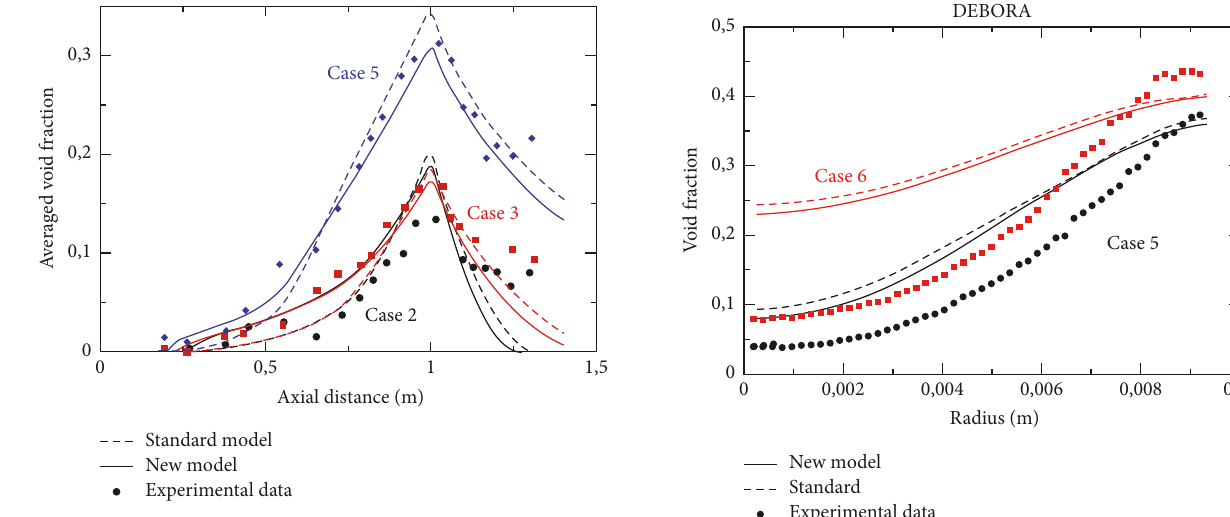
Figure 51: Bartolomei cases 2 (black), 3 (red), and 5 (blue): comparison between the new and the standard model. Table 7: Experimental conditions retained for DEBORA experi- ments.